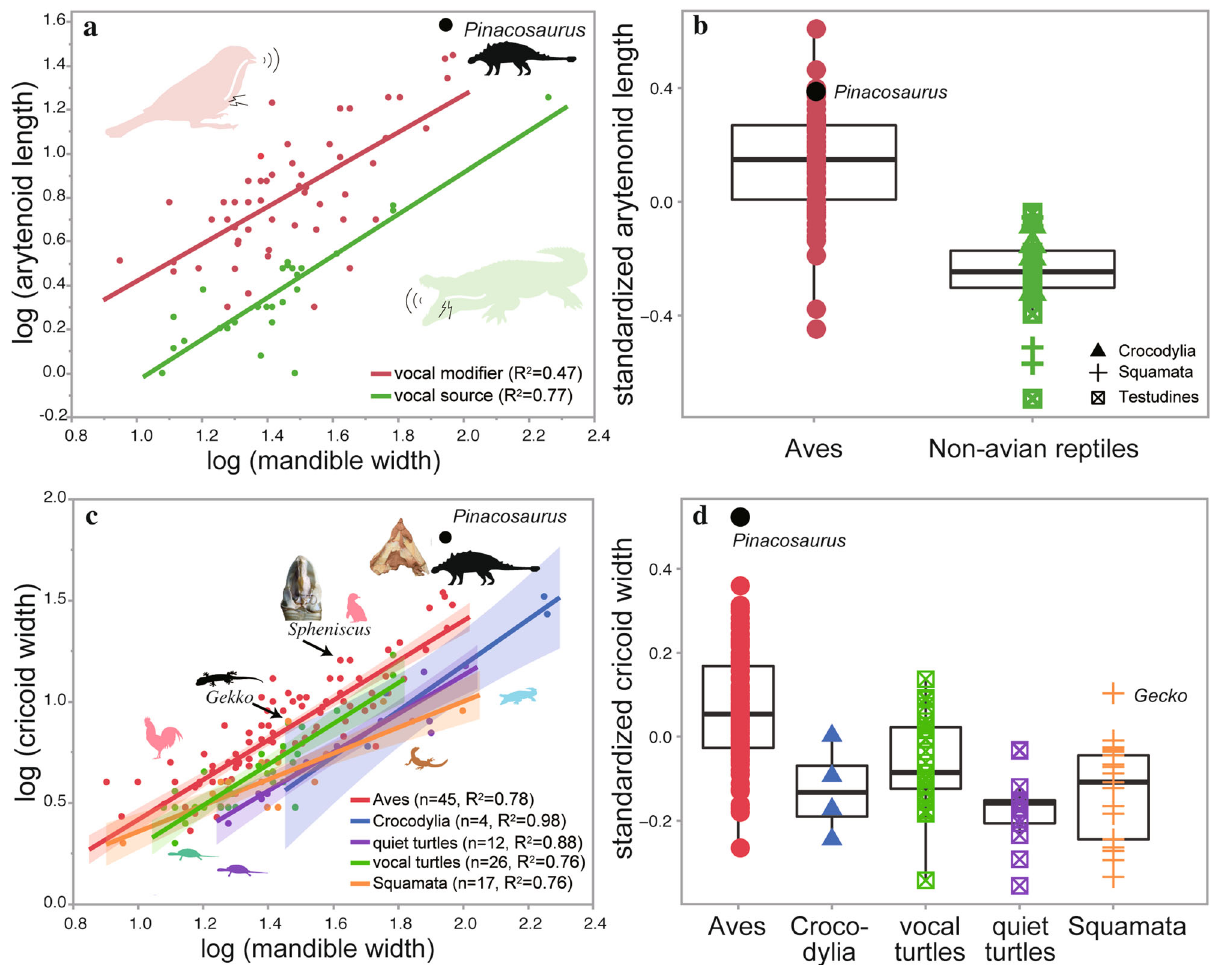
Fig. 2 Morphometrics of larynges of reptiles and birds. a Size of arytenoid (length) to mandible width in reptiles ( n = 31) and birds ( n = 58). ( b ) Box-plot of the standardized arytenoid length between birds and non-avian reptiles. c Size of cricoid (width) to mandible width in reptiles ( n = 62) and birds ( n = 90). d Box-plot of the standardized cricoid width among birds and non-avian reptiles. Linear regression lines showing the 95% con fi dence intervals of Ordinary Least Squares in a , c . Silhouettes from Phylopic (http://phylopic.org) by Andrew Farke, Dysalatornis, Michael Keesey, and Steven